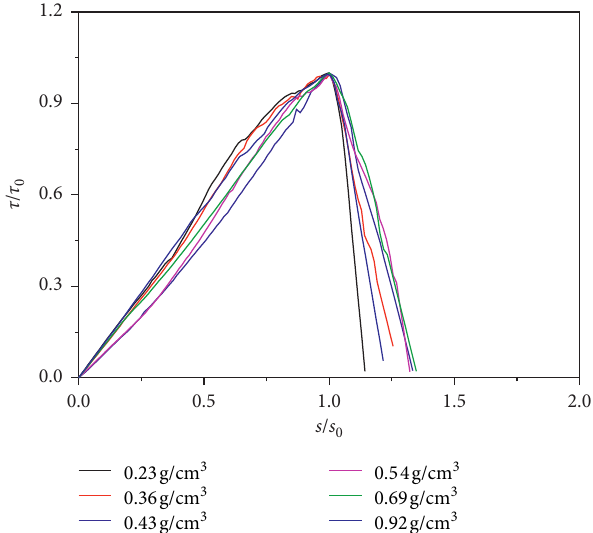
Figure 9: Normalized bond stress-slip curves for specimens under no normal